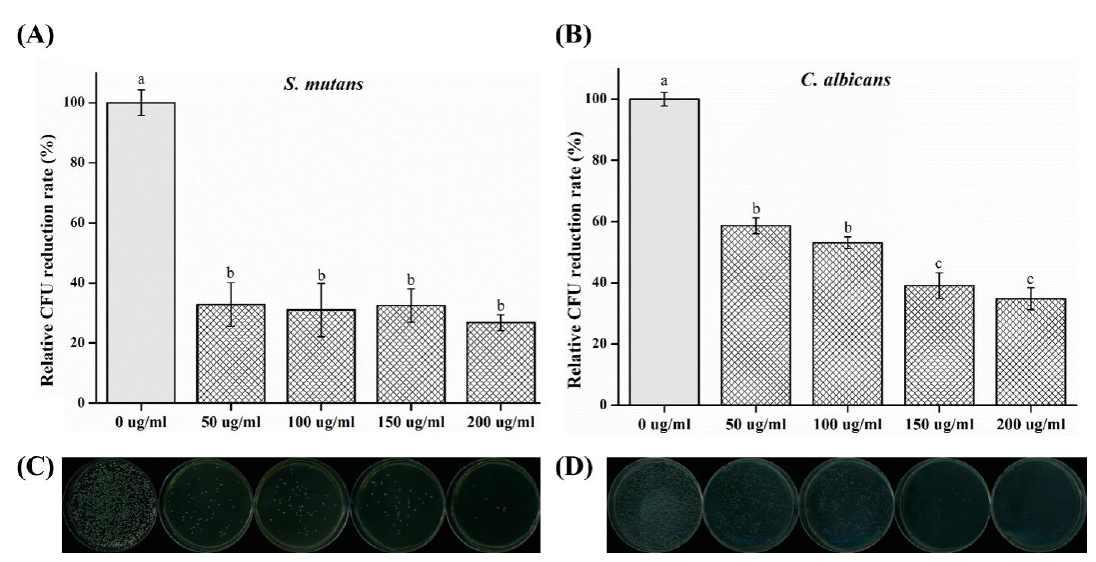
Figure 2. Relativecolony-formingunit(CFU)reductionratefor( A ) S.mutans and( B ) C.albicans . ( C , D )Images Figure 2. Relative colony-forming unit (CFU) reduction rate for ( A ) S. mutans and ( B ) C. albicans . ( C , D ) of agar plates with ( C ) S. mutans and ( D ) C. albicans . Di ff erent letters above bars indicate significant Images of agar plates with ( C ) S. mutans and ( D ) C. albicans . Different letters above bars indicate di ff erences ( p < 0.05). significant differences ( p < 0.05).